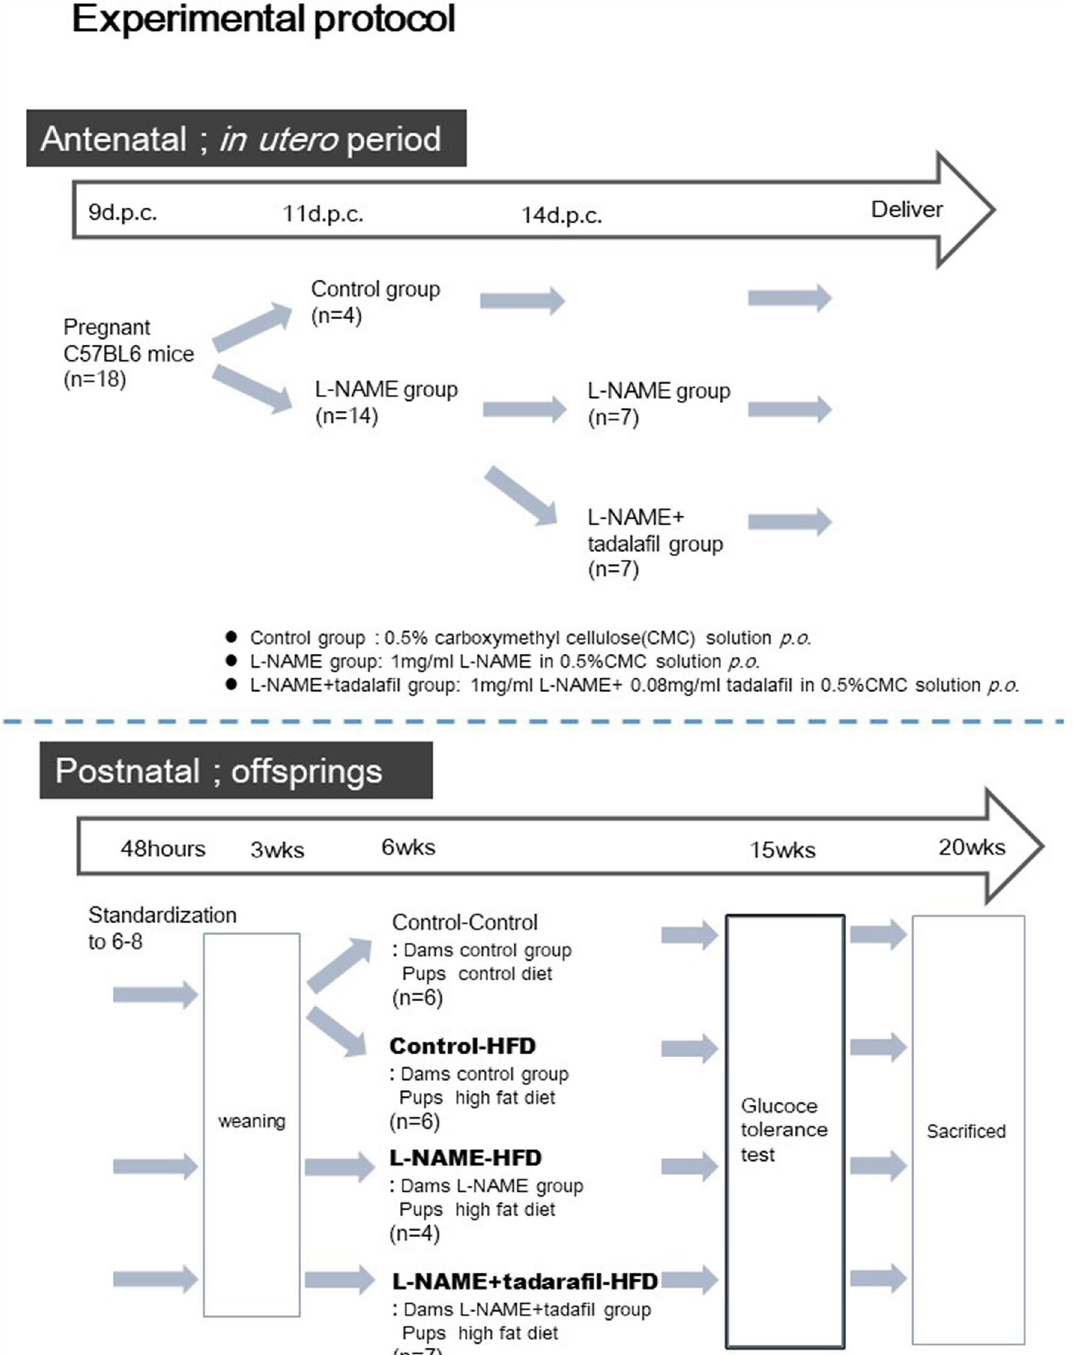
Figure 5. Experimental protocol. The litters were standardized to 6–8 pups per litter 48-h post-partum, allowing the pups to receive equal amounts of milk and maternal pup care. All dams were given normal drinking water during lactation. After 6 weeks, the male pups from each group were fed an HFD and treated as follows: control + HFD (C + H, n = 6), L-NAME + HFD (L + H, n = 4), and L-NAME + tadalafil + HFD (TL + H, n = 7). HFD high-fat diet, L-NAME L-NG-nitroarginine methyl